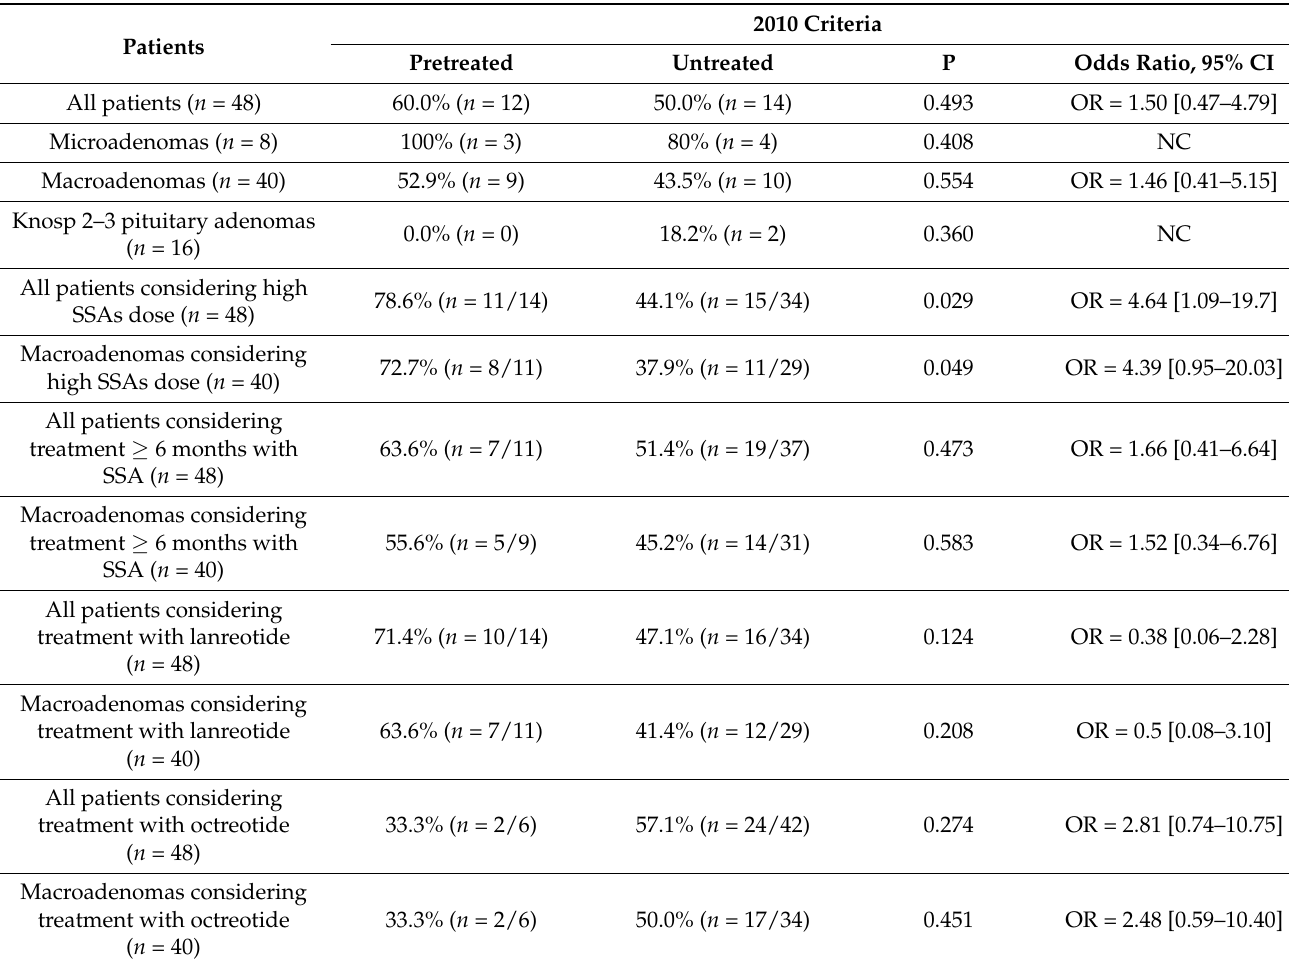
Table 2. Surgical remission in patients with acromegaly pre-treated with somatostatin analogues and untreated, according to the type of somatostatin analogue and its dose and